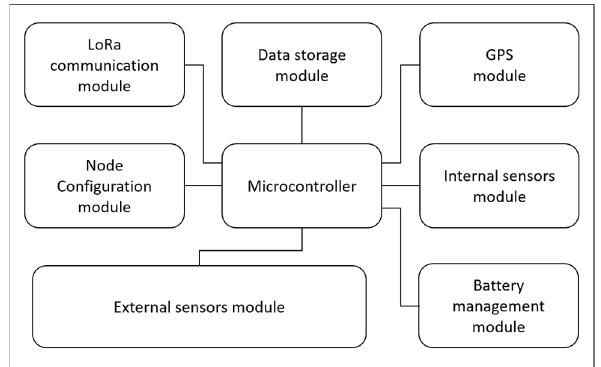
Figure 3. SoLo node hardware architecture built around an STM32 microcontroller.